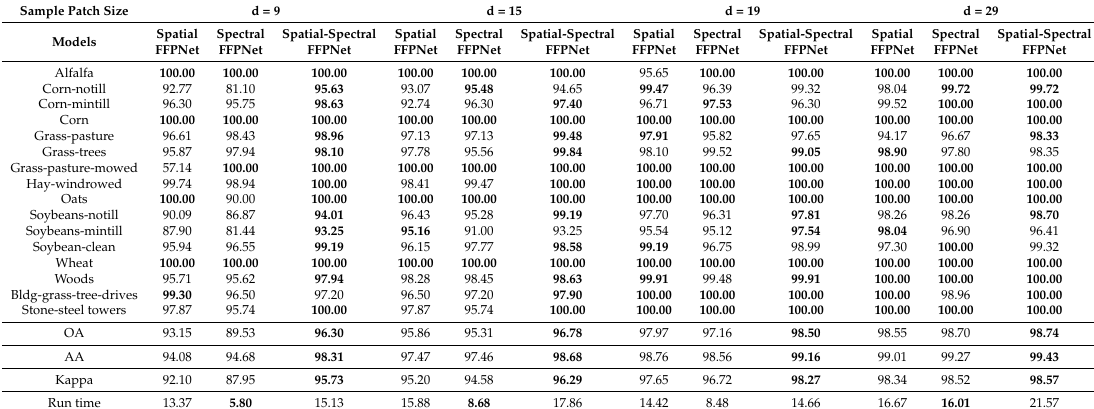
Table 15. Ablation study of the spatial FFPNet, spectral FFPNet, and spatial-spectral FFPNet with sample patch sizes of d = 9, 15, 19, and 29 and 100 samples per category on the IP dataset; the values in bold are the best. All results are the average of three runs with maximum epoch = 200 and mini-batch size = 24.